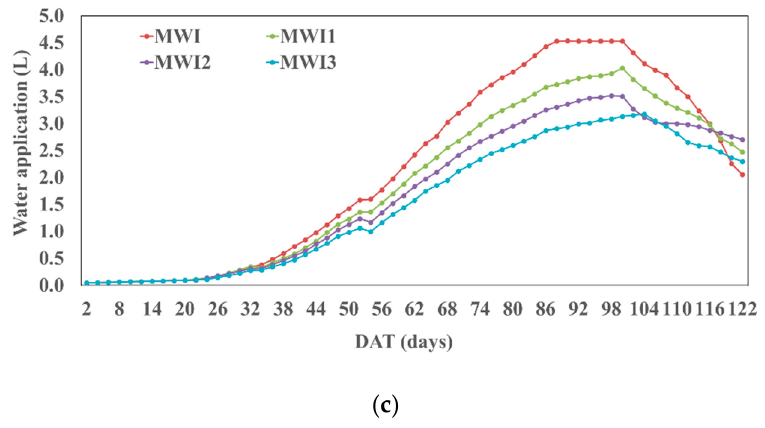
Figure 2. Applied GW ( a ), RW ( b ) and MW ( c ) throughout the growing season for different DI level in experimental year 2017–2018.